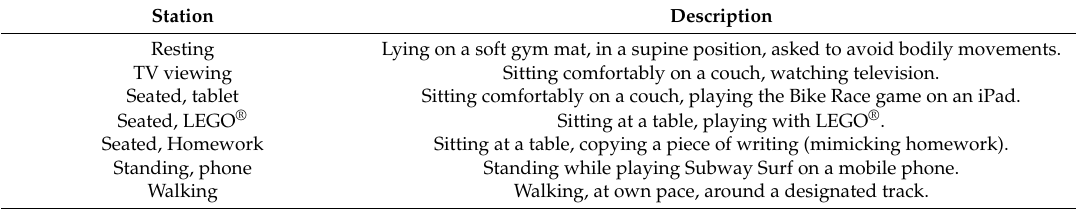
Table 1. Description of the seven sedentary behaviour and light physical activity